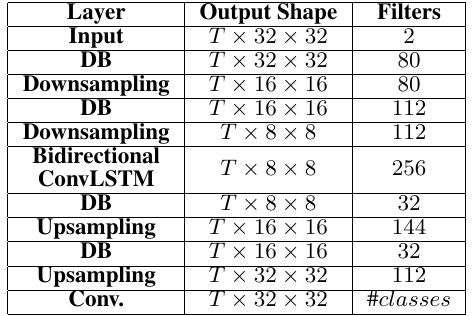
Table 3. BDenseConvLSTM parameter configuration - T is the sequence